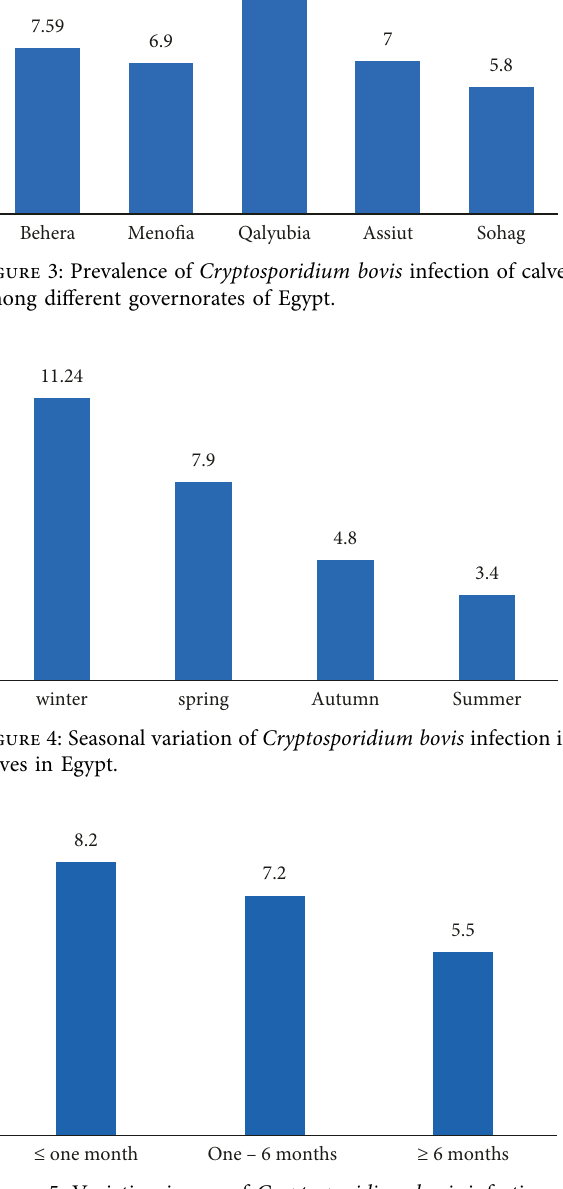
Figure 5: Variation in age of Cryptosporidium bovis infection of calves in